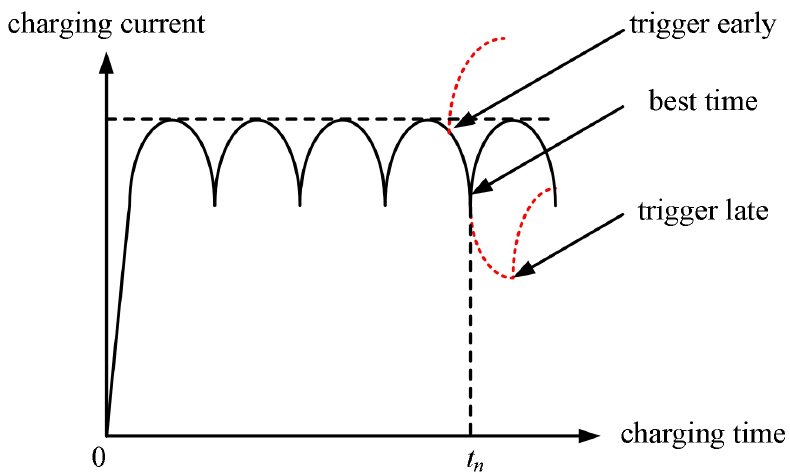
Figure 3. The charging current in the charging